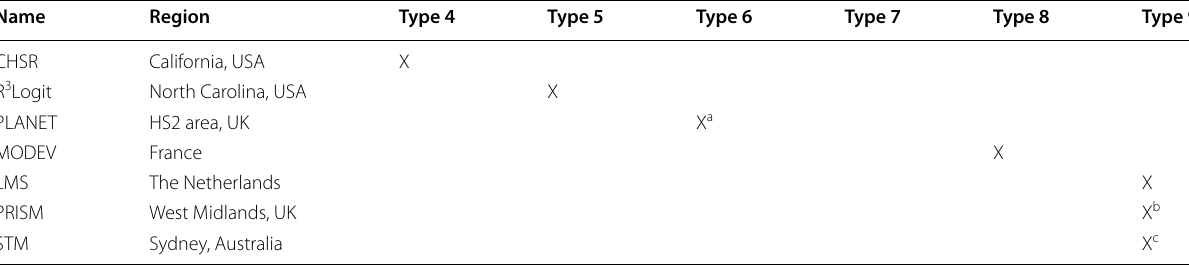
a Egress mode choice is not included b Egress mode choice and terminal choice for the last terminal is not included c Egress mode choice and terminal choice for the last terminal is not